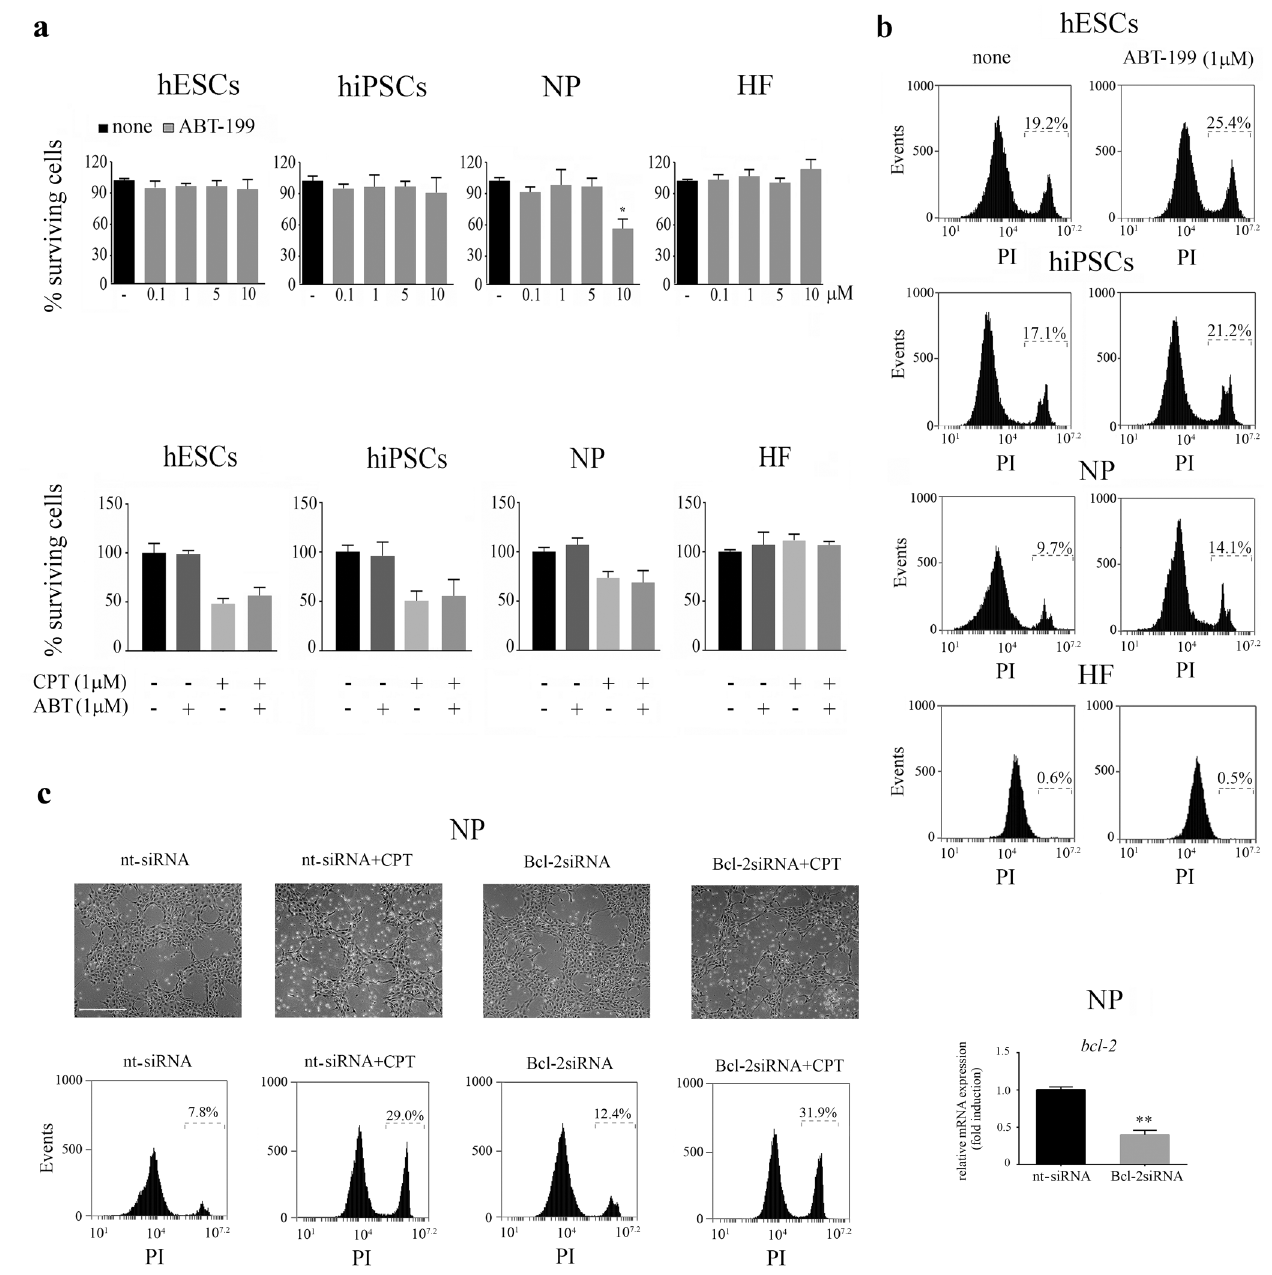
Fig 7. Effects of Bcl-2 selective inhibitor, ABT-199 on the viability of hESCs, hiPSCs NP and HF. (a) H9 hESCs, FN2.1 hiPSCs, hESCs-derived NP and HF were left untreated or treated with increasing concentrations of ABT-199 (0.1 – 10 μ M) during 15 h (top panel) or treated with CPT(1 μ M) for 3h or pre- treated with ABT-199 (1 μ M) for 1 h and then treated with CPT (1 μ M) during 3h (bottom panel). Cell viability was measured by the XTT/PMS assay 15 h post ABT-199 addition or 6 h after CPT removal. Results are presented as the percentage of the viability of untreated cells. Each bar represents the mean ± SEM of three independent experiments performed in quintuplicate. A paired Student's t test was used to compare ABT-199-treated samples with untreated ones (top panel) or CPT plus ABT-199 treated samples to CPT treated ones (bottom panel) * P < 0.05 (b) Representative histograms of PI- stained ABT-199 treated cells over a 20 h period or untreated unfixed cells. Percentage of PI positive cells (late apoptotic or necrotic) was determined by flow cytometric analysis (c) NP were transfected with nt-siRNA or Bcl-2 siRNA and exposed to CPT (1 μ Mduring 3h) 48 h post-transfection. Representative pictures showing nt-siRNA or Bcl-2 siRNA transfected NP treated or not with 1 μ M CPT for 3 h (48 h post-transfection). Images were captured 12 h after genotoxic removal. The scale bars represent 100 μ m. Representative histograms of PI-stained transfected cells 12 h after genotoxic removal (left panel). mRNA expression levels of bcl-2 in nt- siRNA and Bcl-2siRNA transfected NP were analyzed by Real Time RT-PCR (right panel). GAPDH expression was used as normalizer. Graph shows mRNA fold induction relative to nt-siRNA transfectants arbitrarily set as 1. ** P < 0.001.